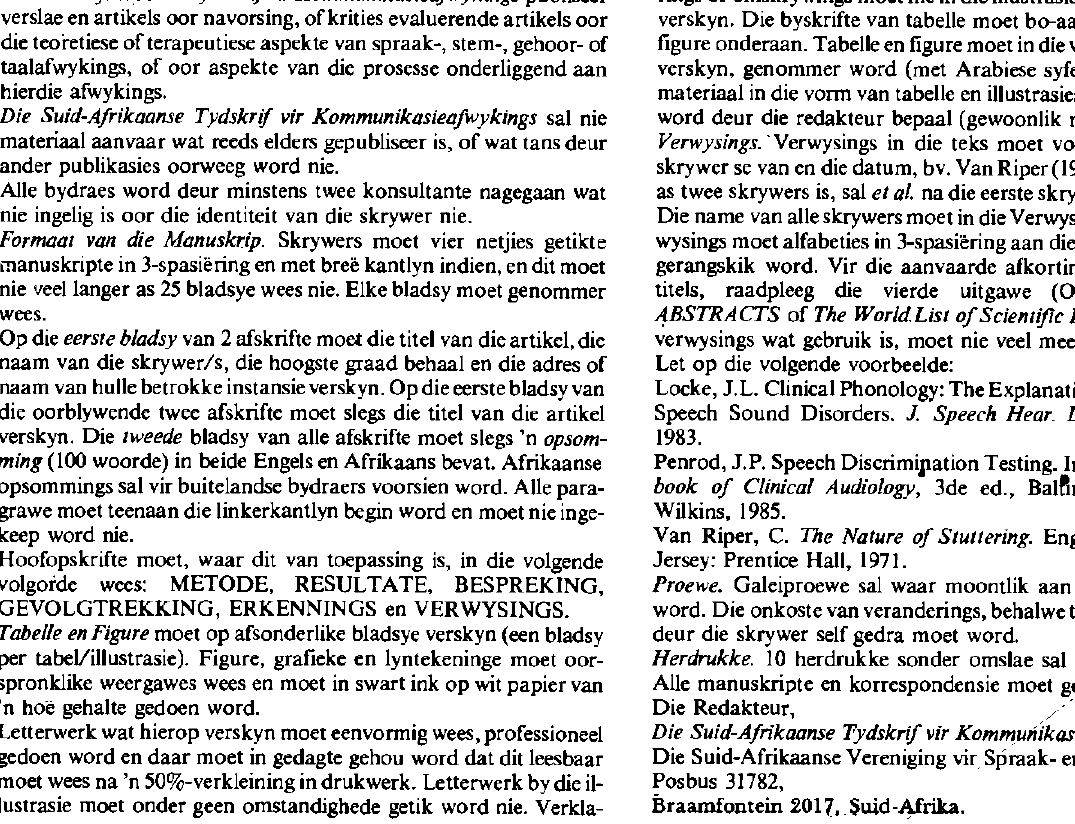
Tabelle en Figure moet op afsonderlike bladsye verskyn (een bladsy per tabel/illustrasie). Figure, grafieke en lyntekeninge moet oor- spronklike weergawes wees en moet in swart ink op wit papier van 'n hoe gehalte gedoen word.